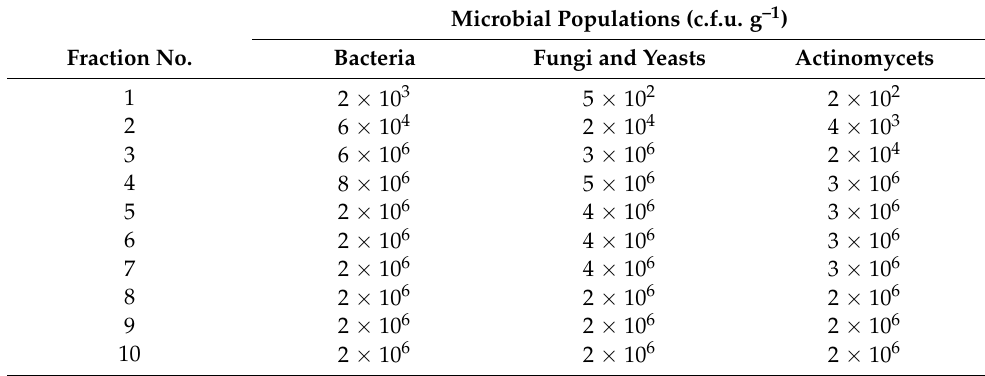
Table 1. Microbial populations during biocatalyst